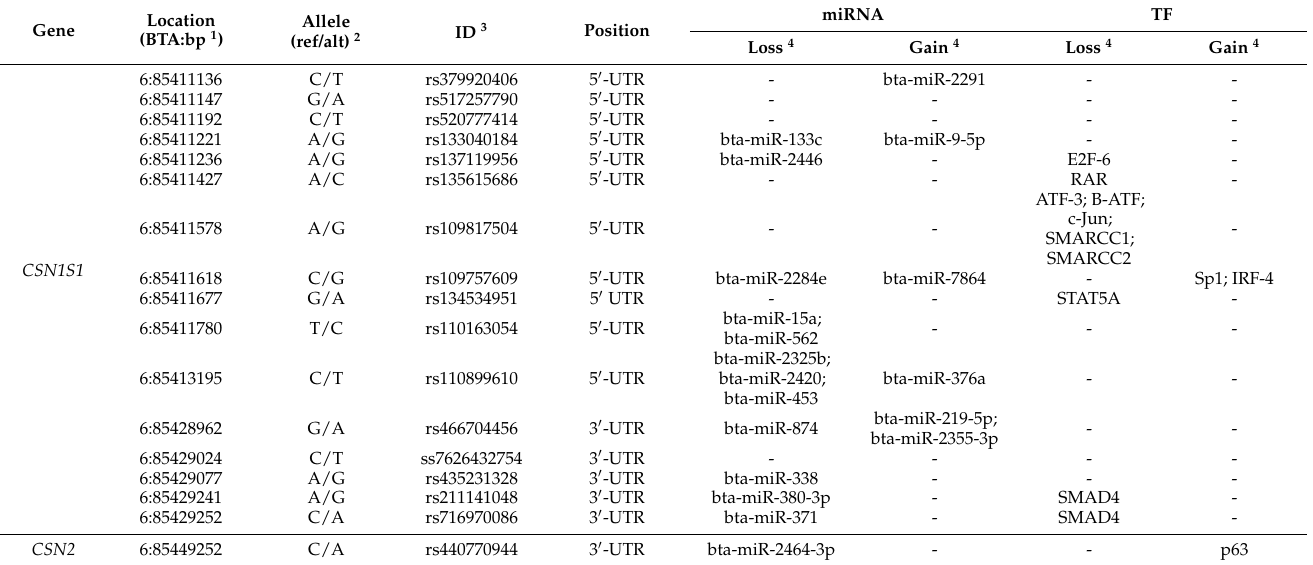
Table 5. Potential effects of SNP positioned within the 5 (cid:48) - and 3 (cid:48) -untranslated regions (UTR) of bovine milk protein genes on the binding of micro-RNA (miRNA) and transcription factors (TF) in Beninese cattle breeds. Location Gene (BTA:bp 1